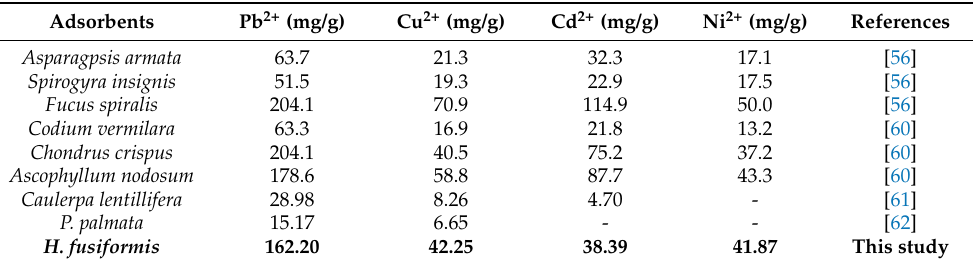
Table 5. Comparison of Langmuir maximum biosorption capacities of pretreated H. fusiformis with other materials.